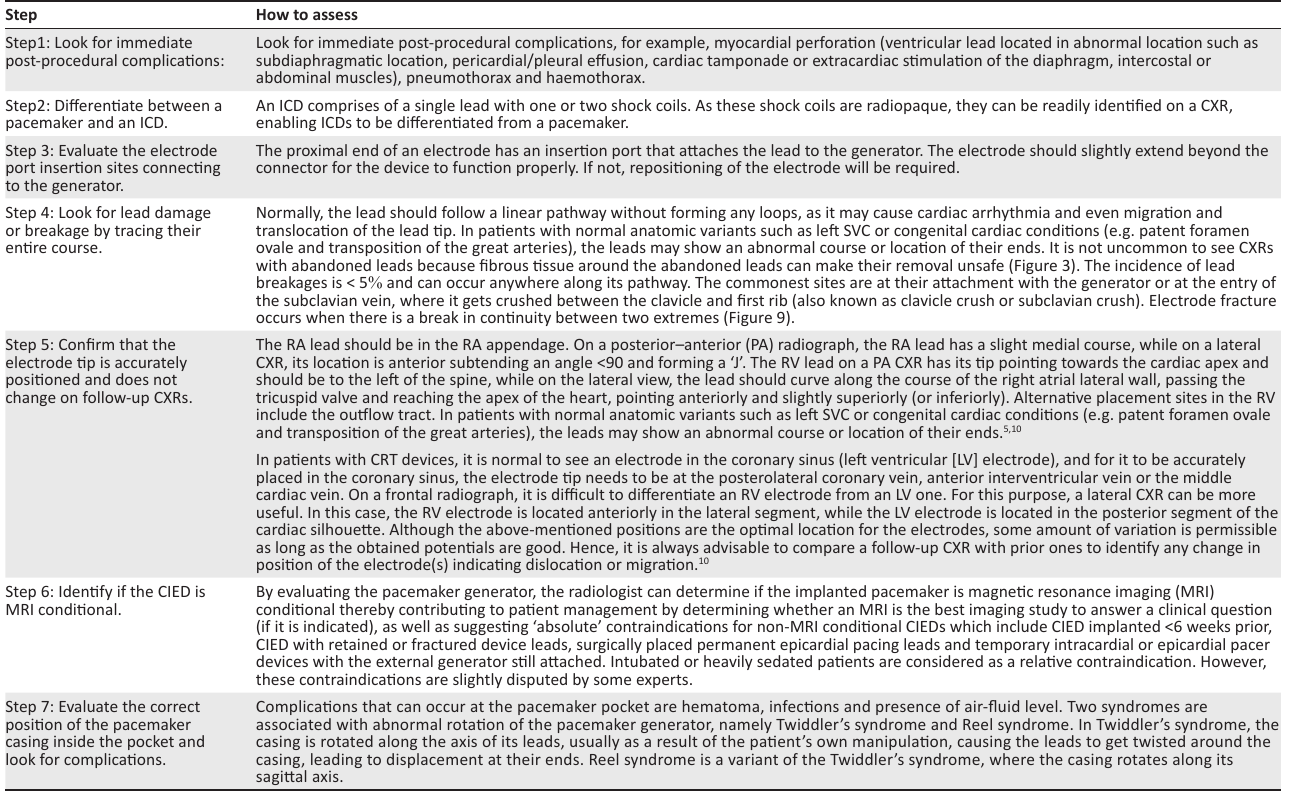
TABLE 1: How to assess cardiac implantable electronic devices on chest radiographs.